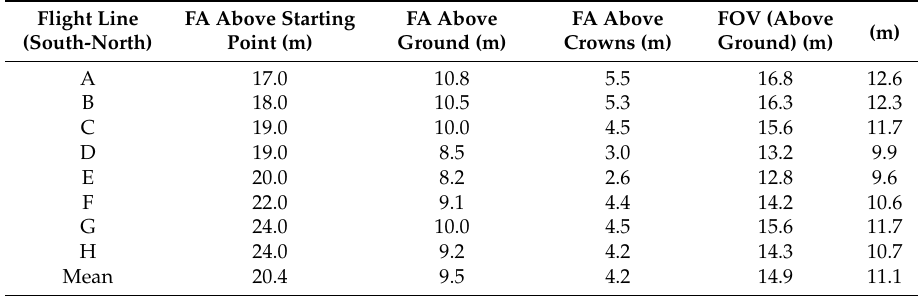
Table 2. Horizontal Analysis: Flying Altitude (FA) of the hexacopter above starting point, ground, and crowns and the Field of View (FOV) above the